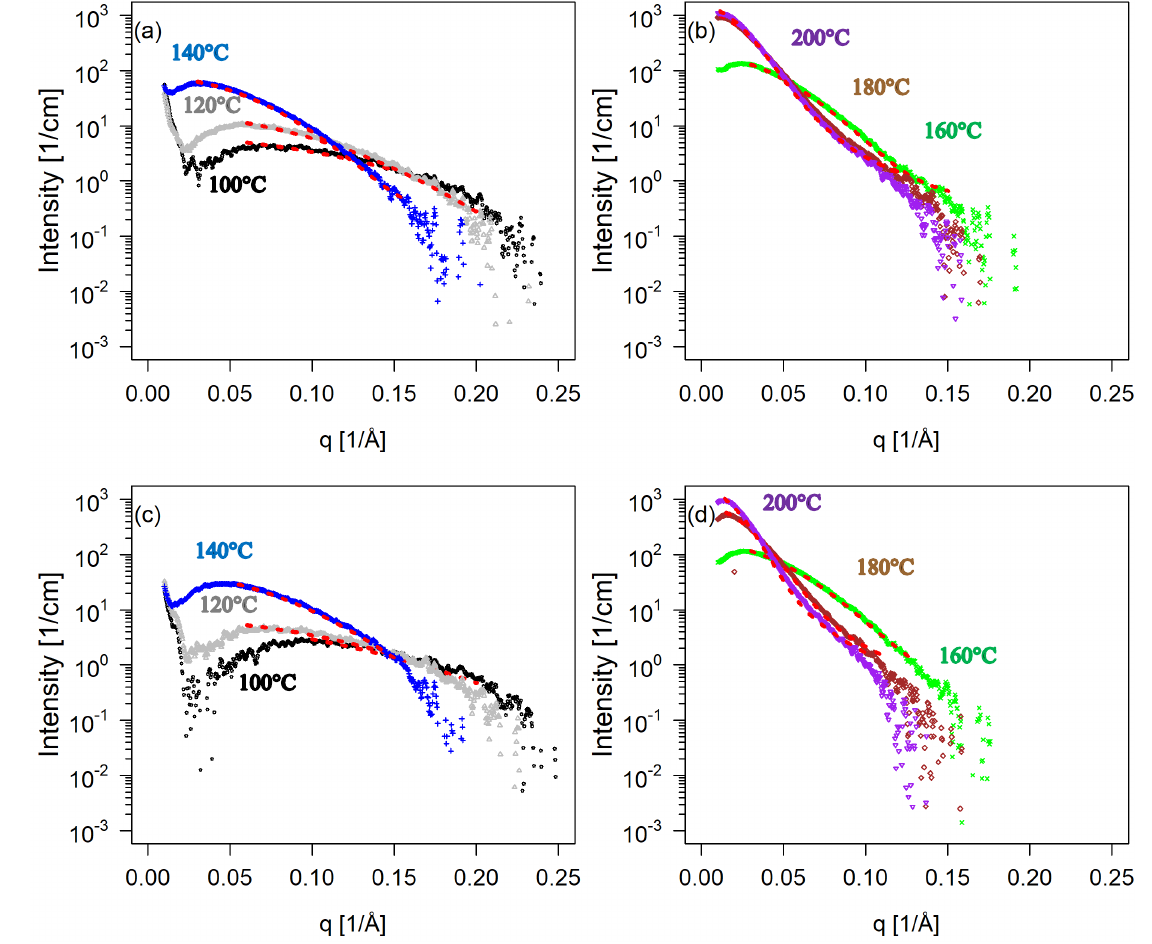
Figure 6. Small-angle X-ray scattering (SAXS) intensity I vs. scattering vector q for ( a ) Al-Zn-Mg-Cu after 100, 120, and 140 °C 3 h isothermal heat treatments; ( b ) Al-Zn-Mg-Cu alloy after 160, 180, and 200 °C 3 h isothermal heat treatments; ( c ) Al-Zn-Mg after 100, 120, and 140 °C 3 h isothermal heat treatments; and ( d ) Al-Zn-Mg alloy after 160, 180, and 200 °C 3 h isothermal heat treatments. For the scattering curves at lower temperatures (e.g., 100 °C, 120 °C, 140 °C), the curves begin